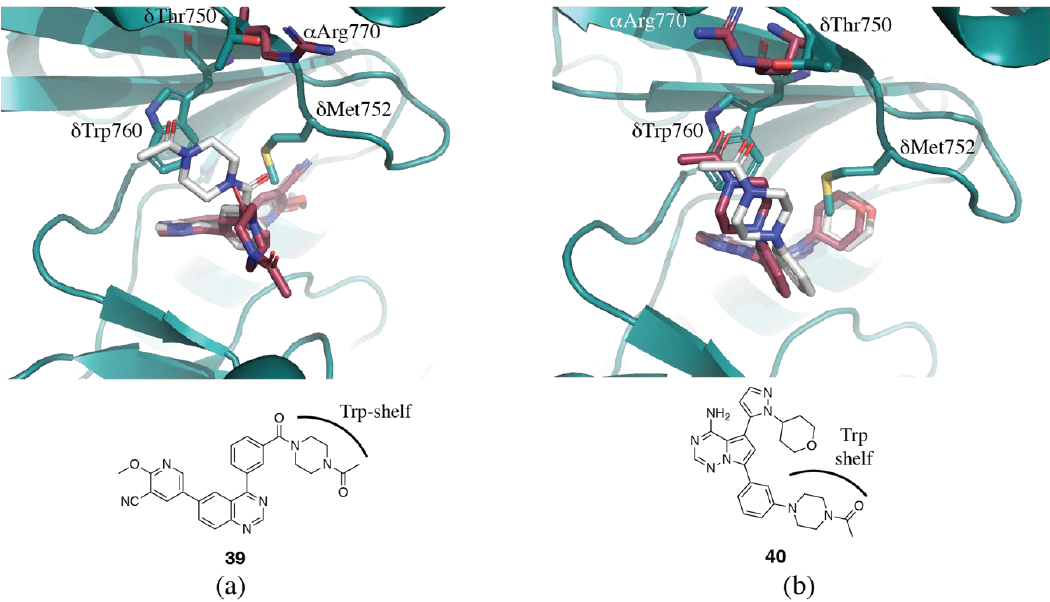
Figure 7. Comparing tryptophan shelf inhibitors in p110 α and p110 δ . ( a ) 39 bound to p110 δ ( 39 in